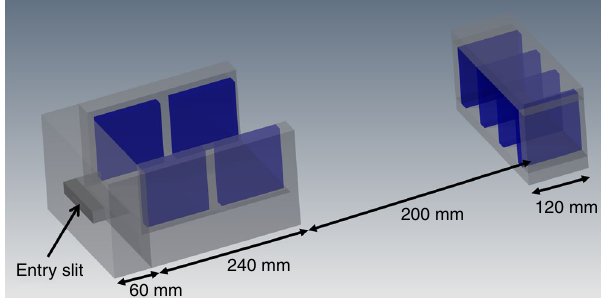
Fig. 8 Ion spectrometer. 3D view of the employed particle spectrometer including relevant dimensions. The ions enter through a 0.5 mm high slit made out of tungsten into the fi rst dipole magnet. After a drift length of 200 mm they enter the second dipole magnet. The detector was located